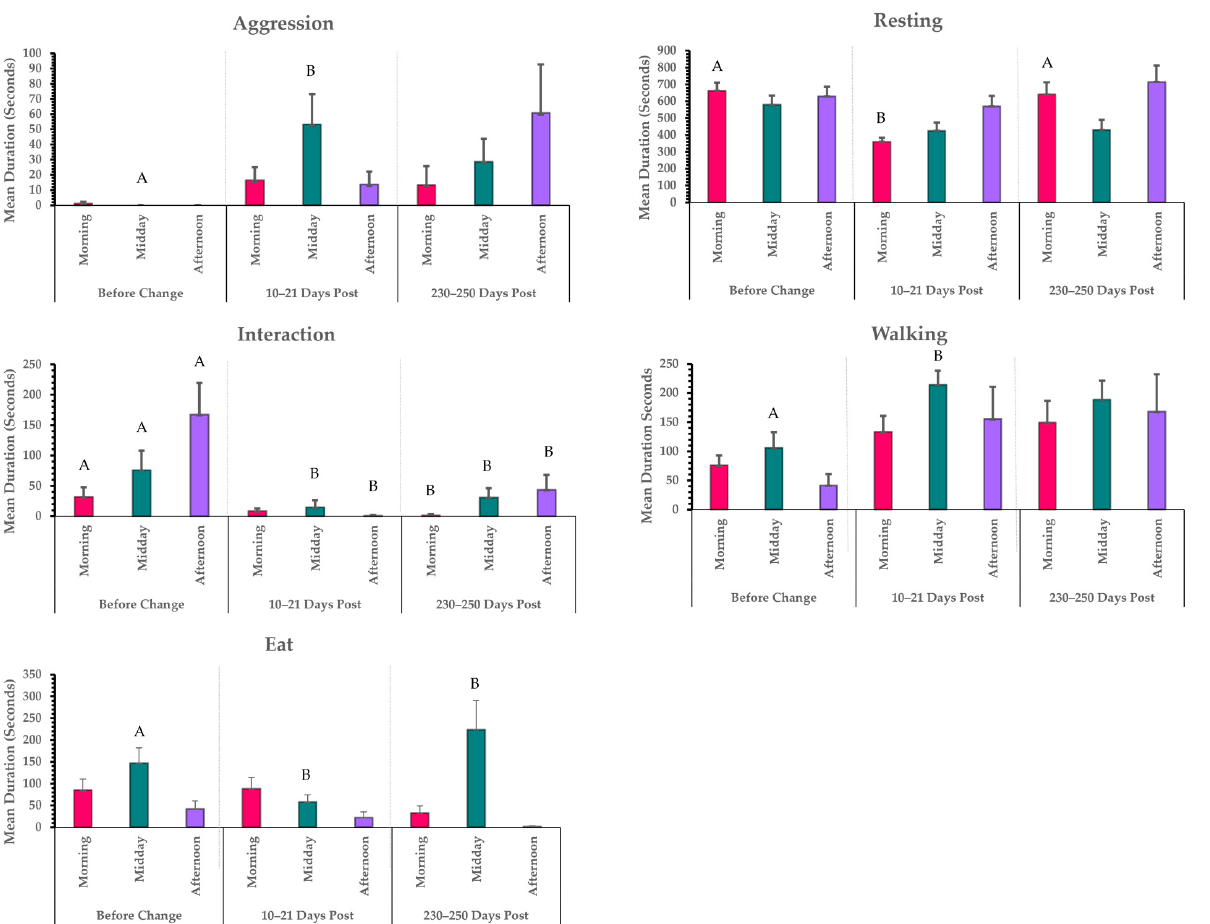
Figure 3. Bar Chart of all significant behaviours separated by time of day at three time points. Pairwise comparisons are indicated with a letter, i.e., the letter ‘A’ over two bars indicates no difference between those time points. Letters ‘A’ and ‘B’ over two bars indicates that these are different from each other within the same time of day comparison, i.e., morning data compared. “Interaction” refers to co-occupant interaction. Displaying mean and standard error.